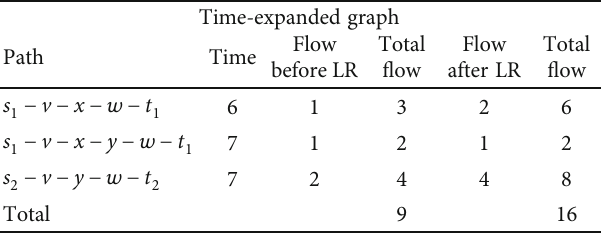
Figure 4: Time-expanded network of Figure 2(b). Table 1: Maximum dynamic multicommodity fl ow before and after lane reversals.